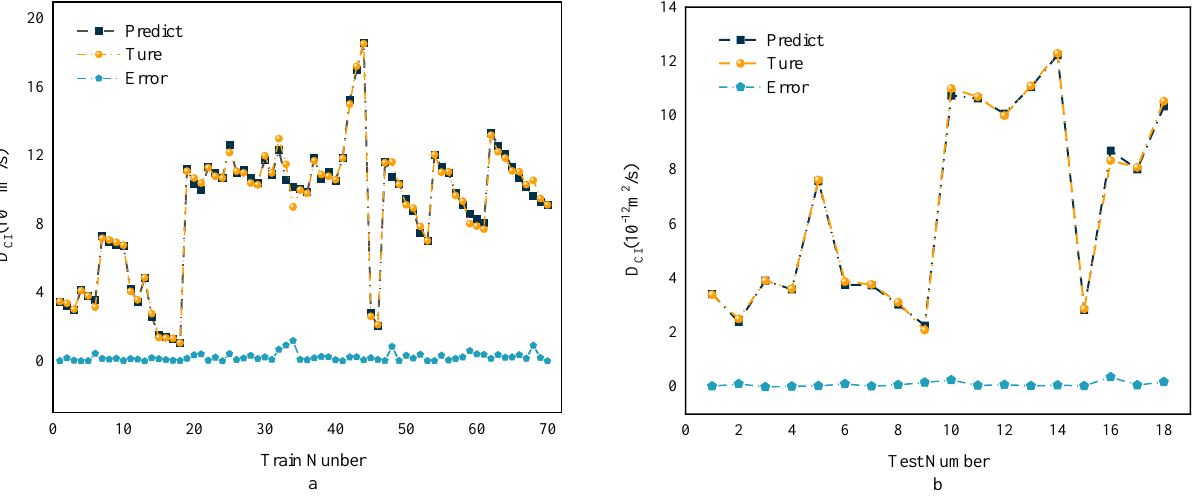
Figure 16. Comparison and error results between the Training ( a ) and Testing ( b ) sets of the MWOA-